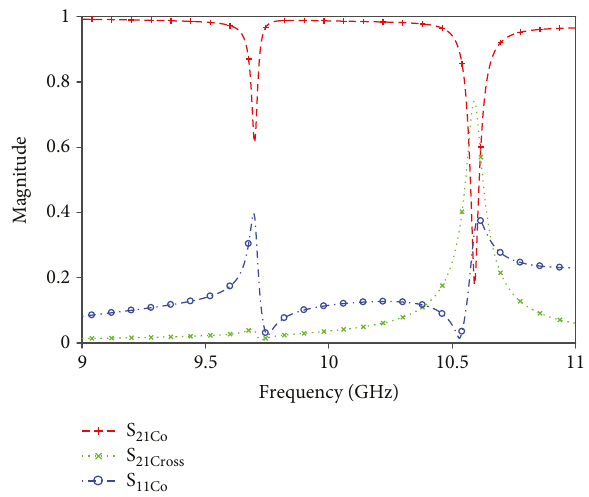
Figure 4: Scattering parameters (magnitude) for a linearly polarized plane wave, normally incident on a structure as shown in Figure 1. Zoom on the 9 – 11GHz